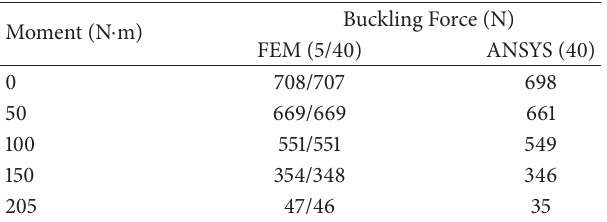
Table 9: Critical buckling force versus end moment; fixed-fixed aluminum